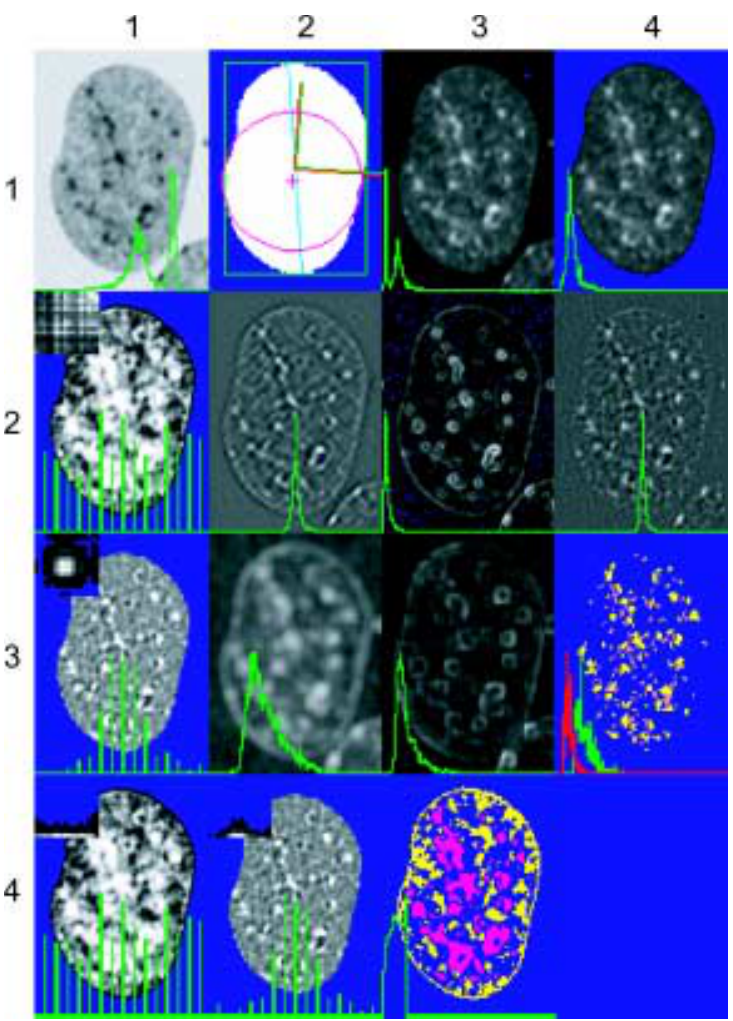
Fig. 12. Feature display during calculation. References are given by (column line) coordinates. (1 1) original image in transmission, (2 1) mask with surrounding box, maximum extension, principal axes and maximum inscribable circle, (3 1) original in extinction ( TO ... , BG ... ), (4 1) object in extinction ( ... , BO ... , BI ... ), (1 2) histogram equalized object in extinction with co-occurrence matrix ( CO ... ), (2 2) Laplace transformation ( L... ), (3 2) gradient transformation ( G... ), (4 2) flat texture transformation ( F ... ), (1 3) linear spread flat texture image with co-occurrence matrix ( NC ... ), (2 3) local fractal dimension ( FR ... ), (3 3) local multi-fractal dimension ( MF ... ) [97], (4 3) particle segmentation from flat texture image ( D ... , H ... ), (1 4) histogram equalized object in extinction with run-length matrix ( RL ... ), (2 4) linear spreaded flat texture image with run-length matrix ( NR ... ), (3 4) Mayall/Young chromatin areas and radial intensity distribution [133], (4 4) original image before shading correction if any was done. This figure can be viewed on